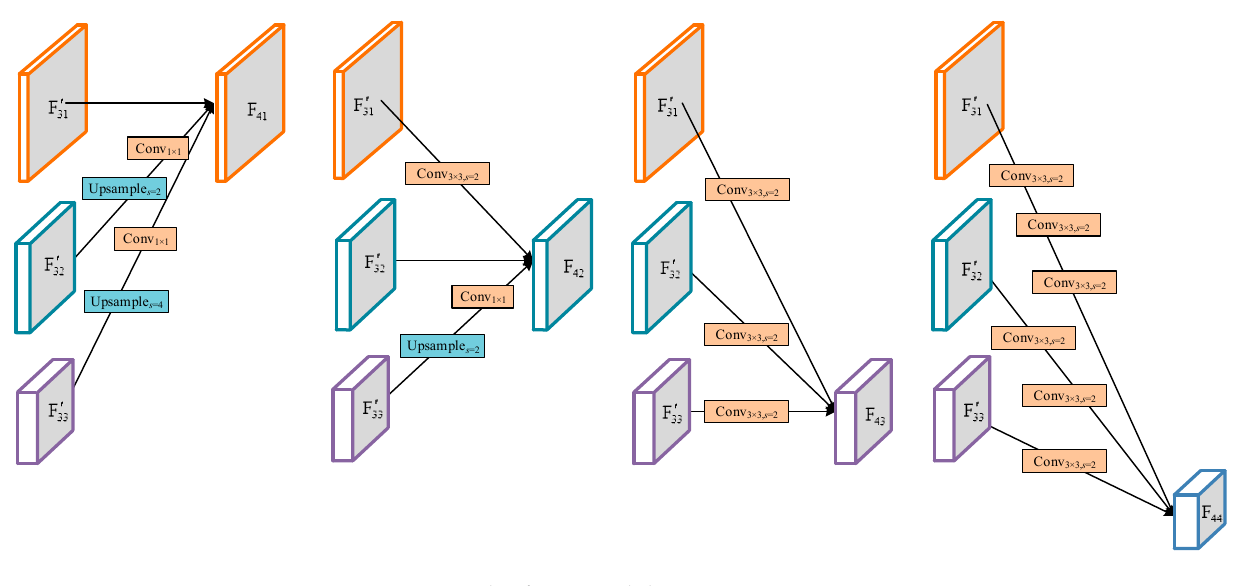
Figure 5. An example of MFF module. The final output features are up-sampled and concatenated for the subsequent FP module.